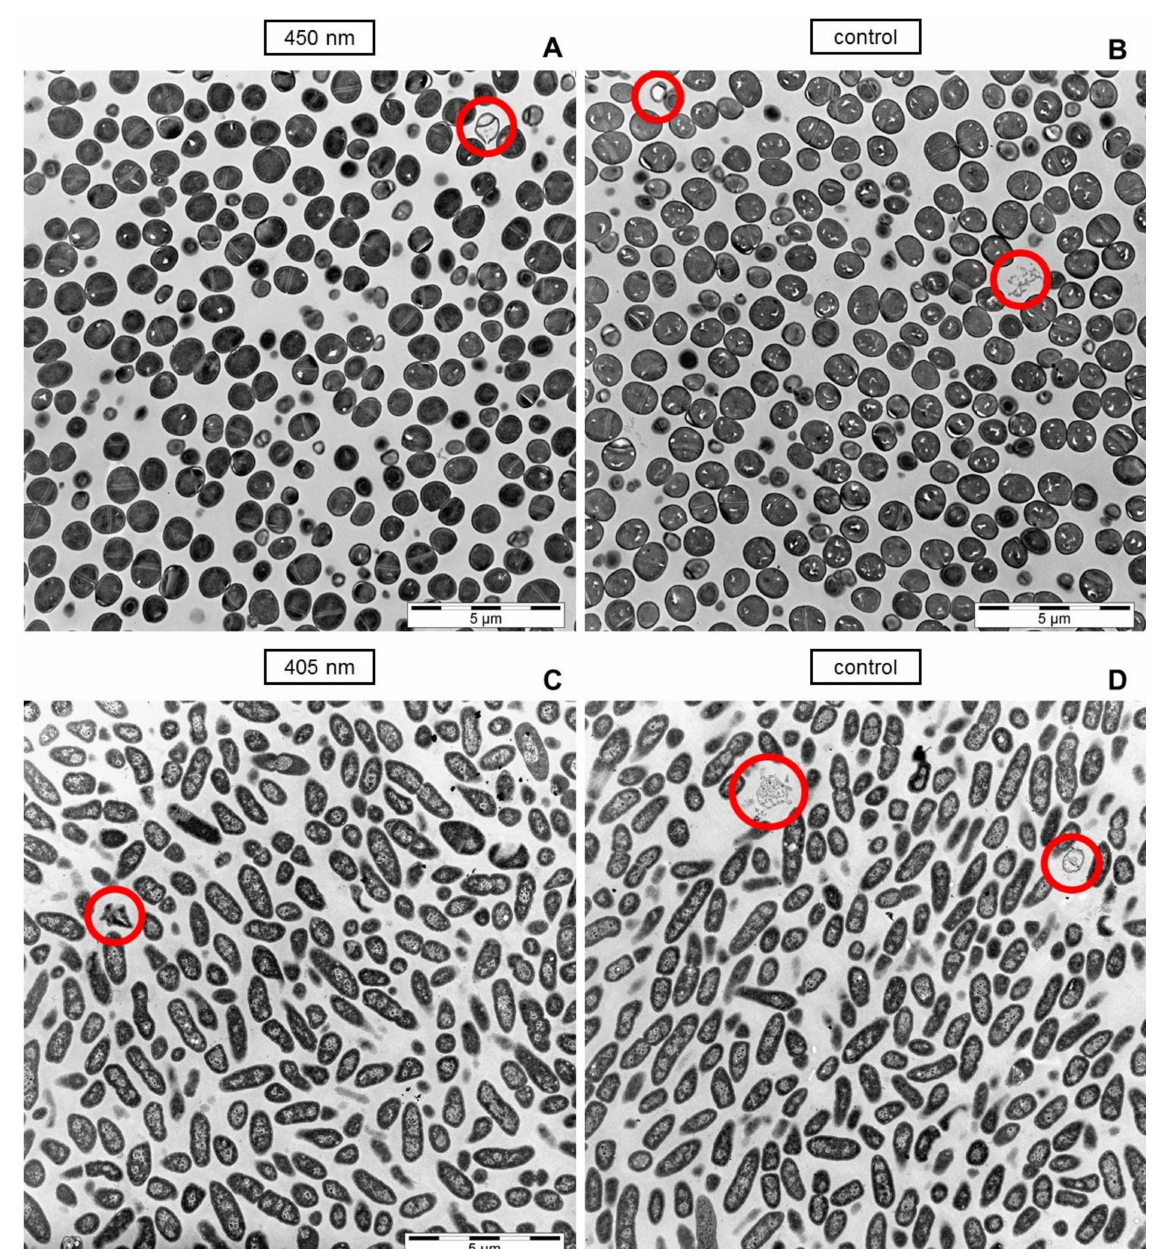
(Figure 5). Irradiation of 450 nm on S. carnosus demonstrated one emptied cell with leaked intracellular material at the top right corner of the image and some lighter shaded cells that might have lost intracellular material (Figure 5A), but the same occurs in the control (Figure 5B) demonstrating an emptied cell on the top left corner and some cell debris at centric right position. For P. fluorescens, single cell envelopes without intracellular material have only been visible on micrographs of the control (Figure 5D), while only moderately affected individual cells could be found on images of 405 nm irradiated samples. Images of S. carnosus irradiated with 405 nm and of P. fluorescence irradiated with 450 nm likewise show the same appearance as their respective controls (data not shown).